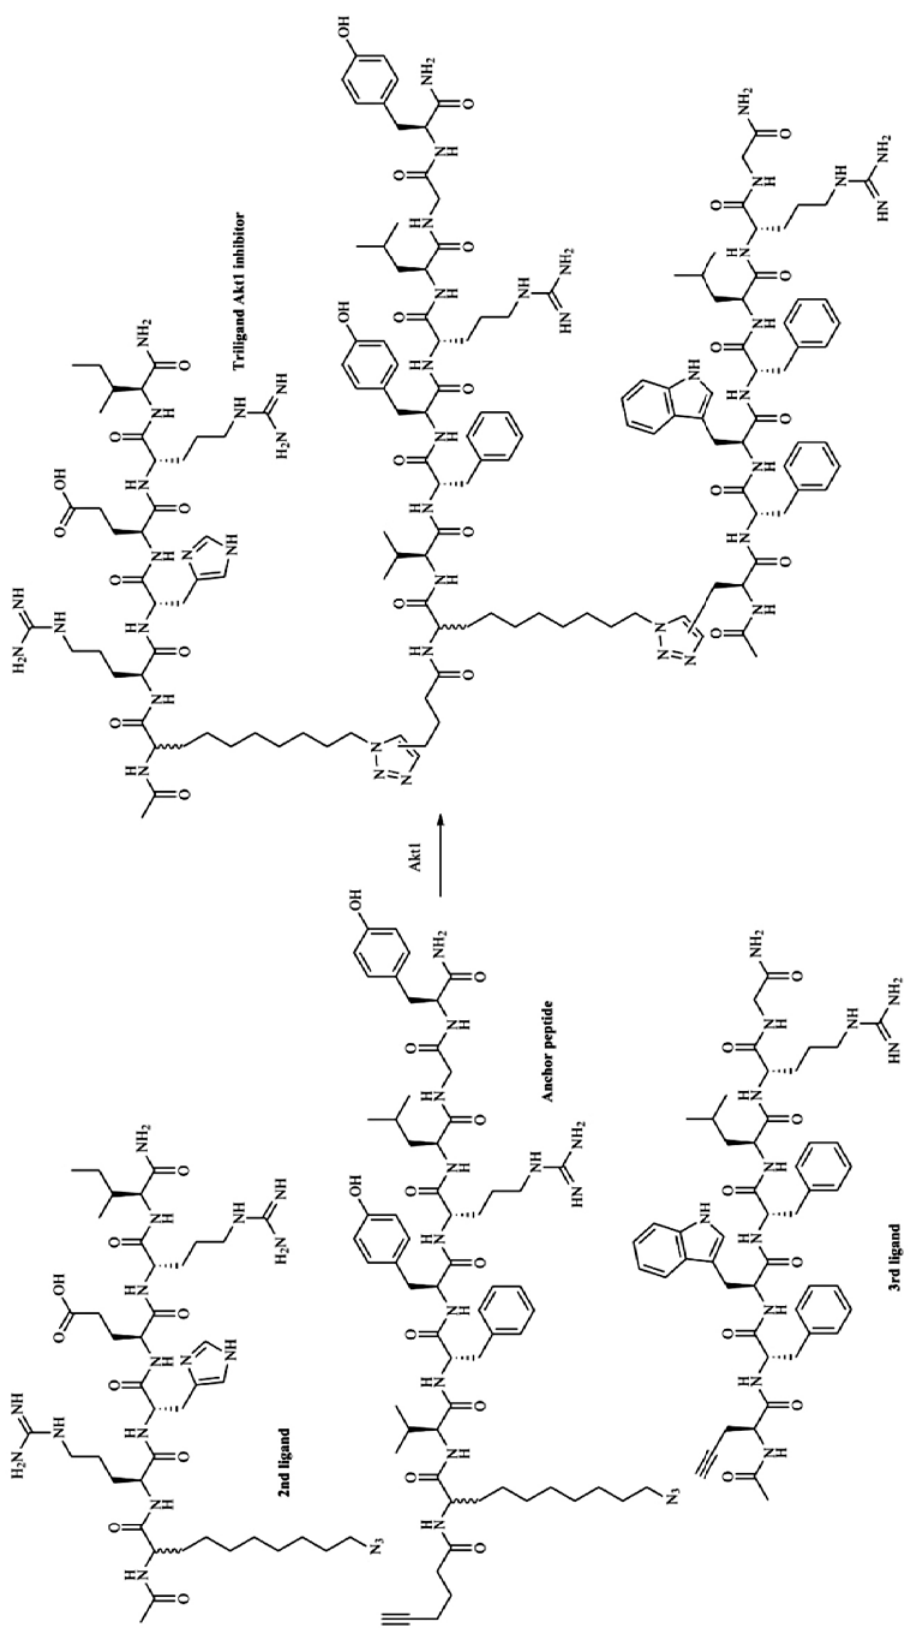
Figure 18. In situ click chemistry approach for developing triligand capture agent/inhibitor for Akt1 kinase.